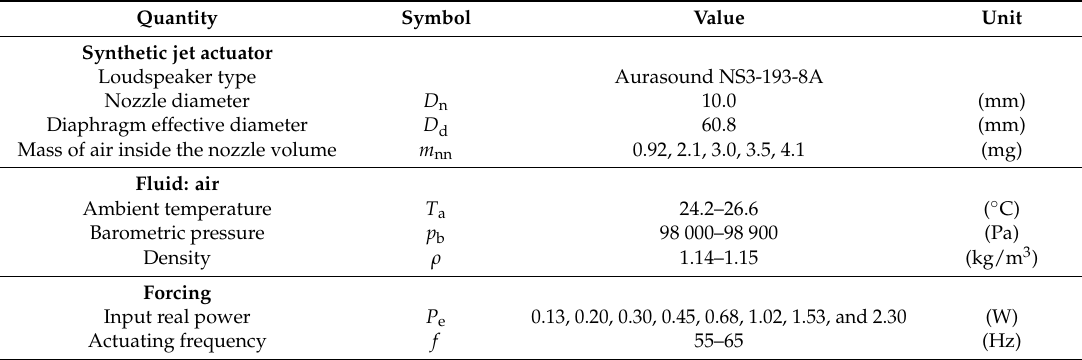
Table 1. Basic properties of the used synthetic jet actuator (SJA), fluid properties and forcing